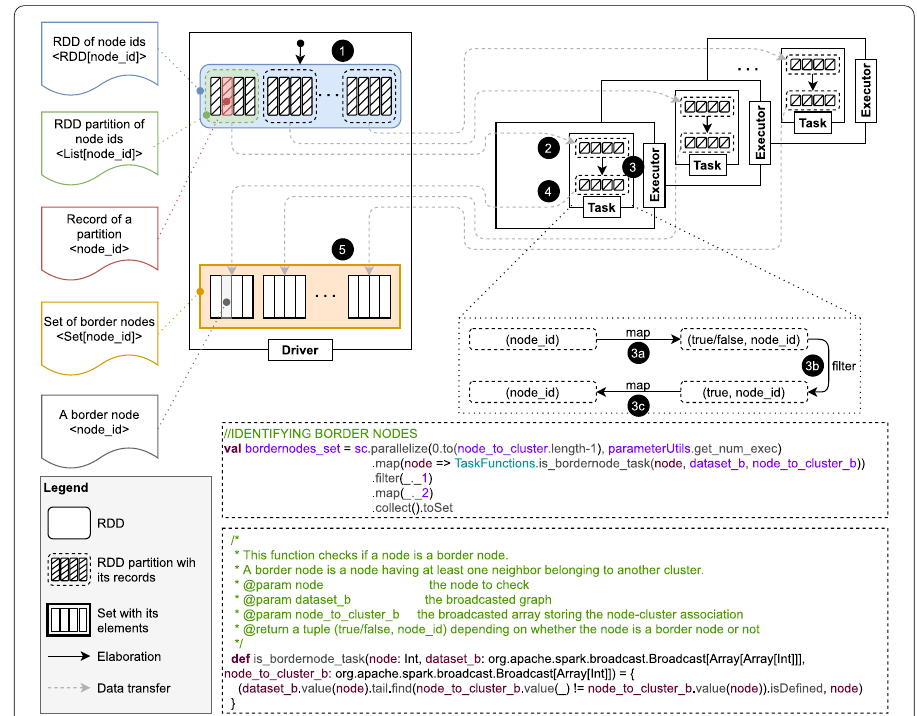
Fig. 6 Map-reduce, detailed description of Job2 Includes elaboration and data transfer phases (solid and dashed arrows), the set of transformations applied by the tasks (dotted box) and the related source code (dashed